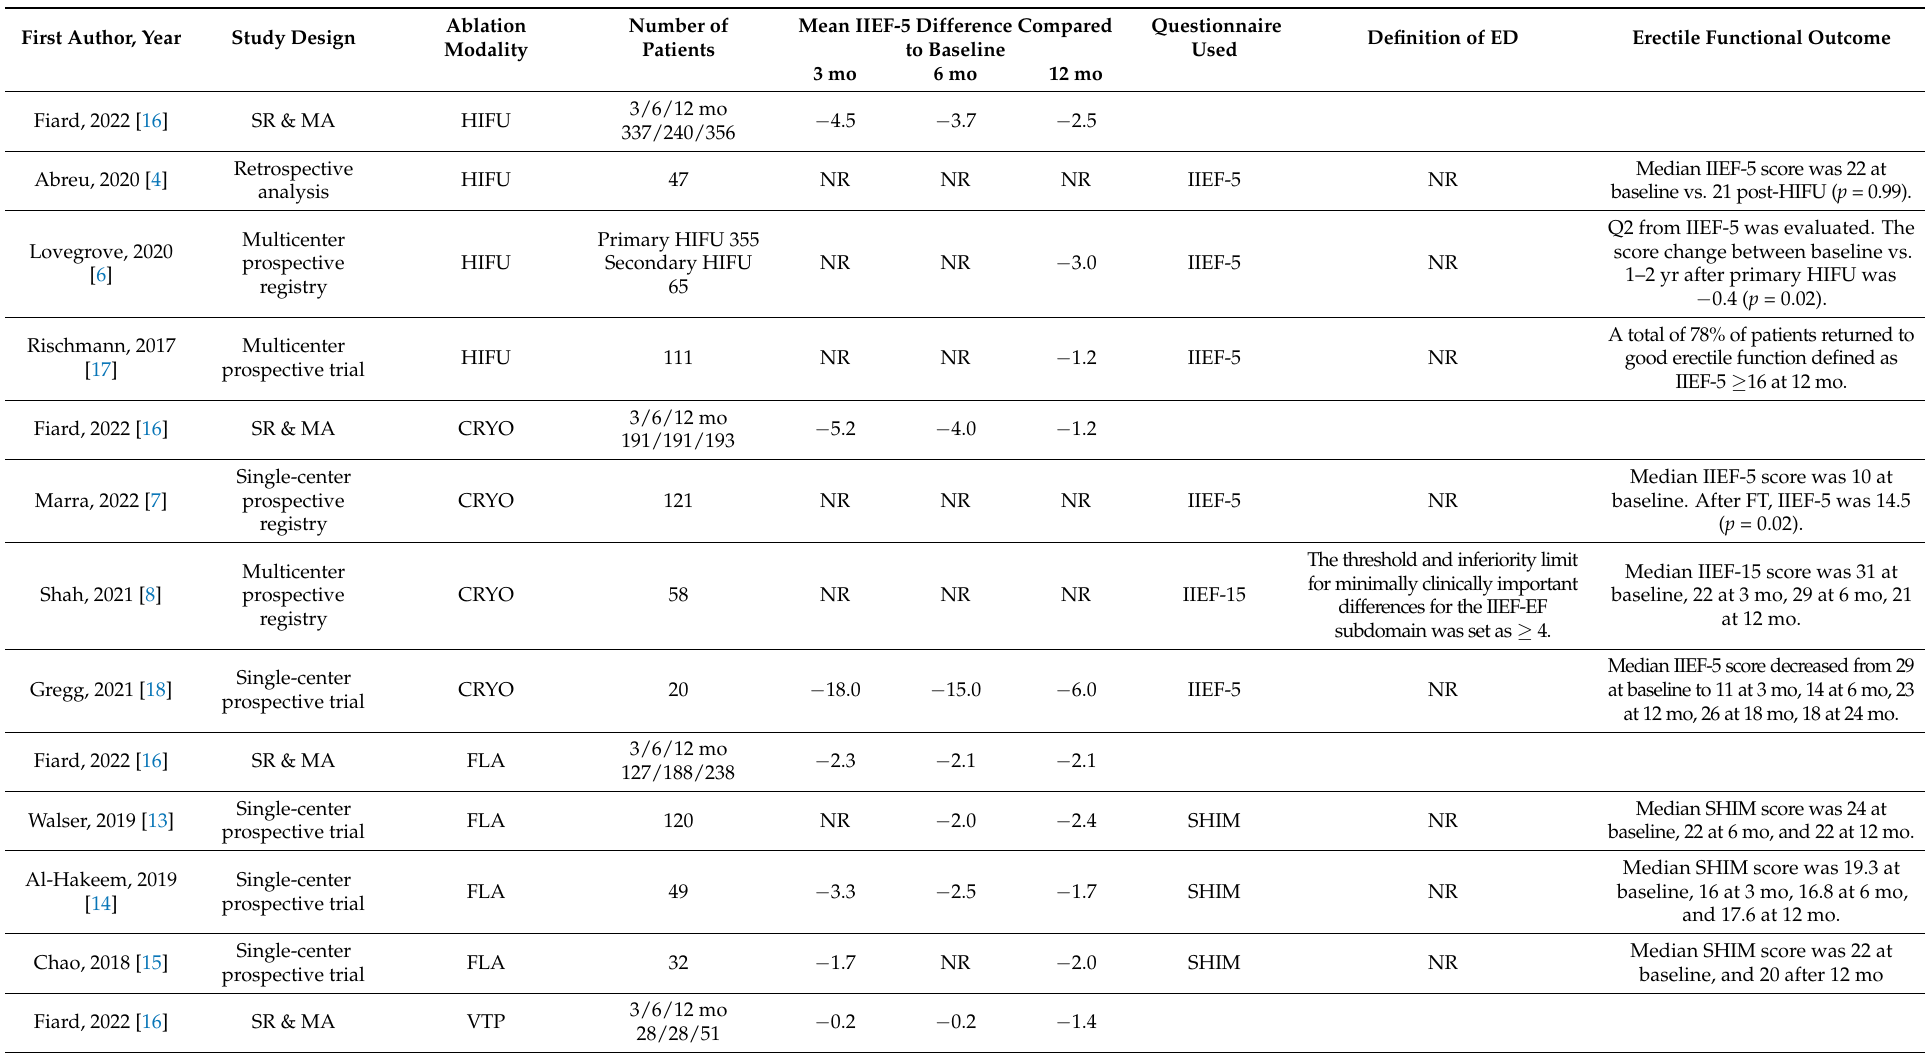
Table 1. Summary of erectile functional outcomes of FT